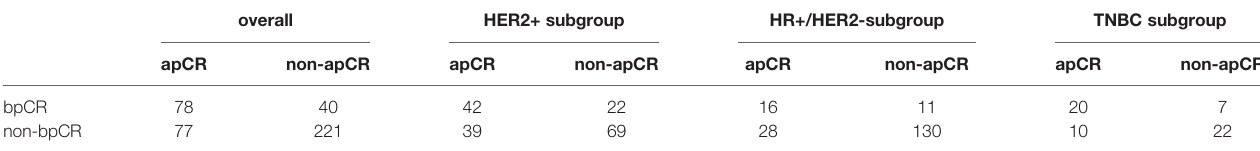
TABLE 1 | The apCR and bpCR after neoadjuvant in different molecular subtypes. overall HER2+ subgroup HR+/HER2-subgroup